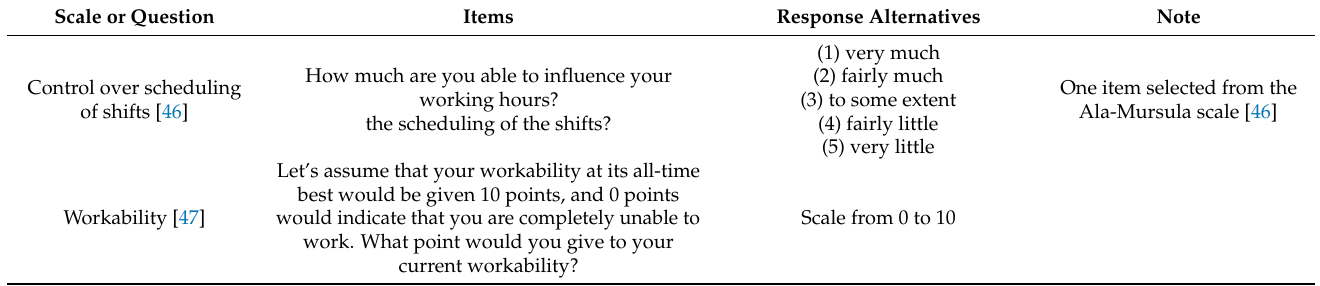
Table A1. References and description of some of the original scales and questions used in the Finnish Public Sector surveys. Scale or Question Control over scheduling of shifts